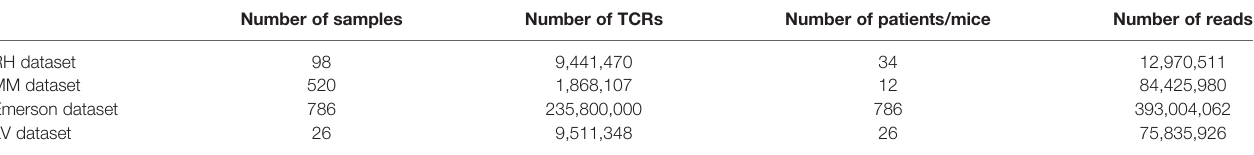
TABLE 2 | Details for each of the datasets. Number of samples Number of